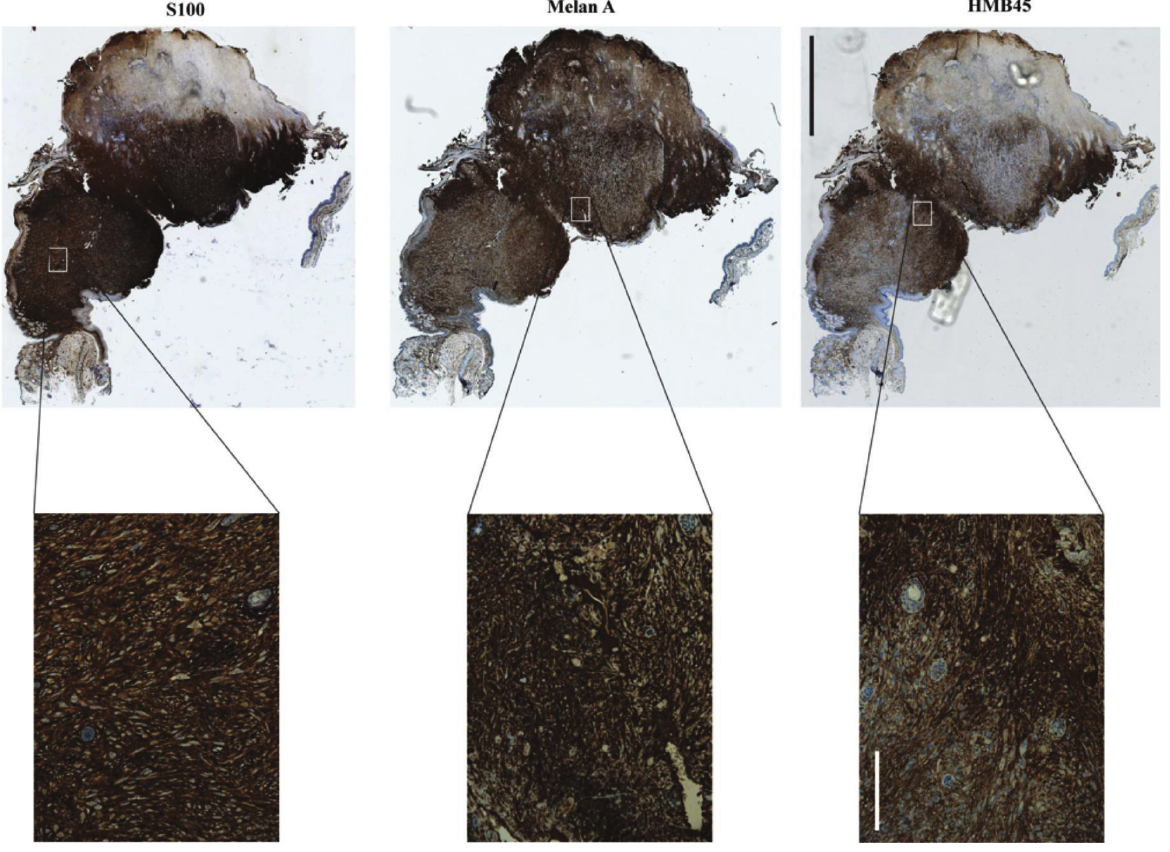
Figure 6. Spontaneous melanoma, which manifested on the ear of a UVB irradiated Cdkn2a −/− , Tyr- HRAS mouse. Staining positivity for all three markers (S100, Melan A and HMB45) as well as their pattern and localization are indicative of melanoma. Scale bars are 2 mm for the low (5×) and 200 μm for the high magnification (20×)